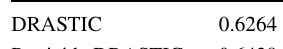
Table 16 R 2 values of the various methods